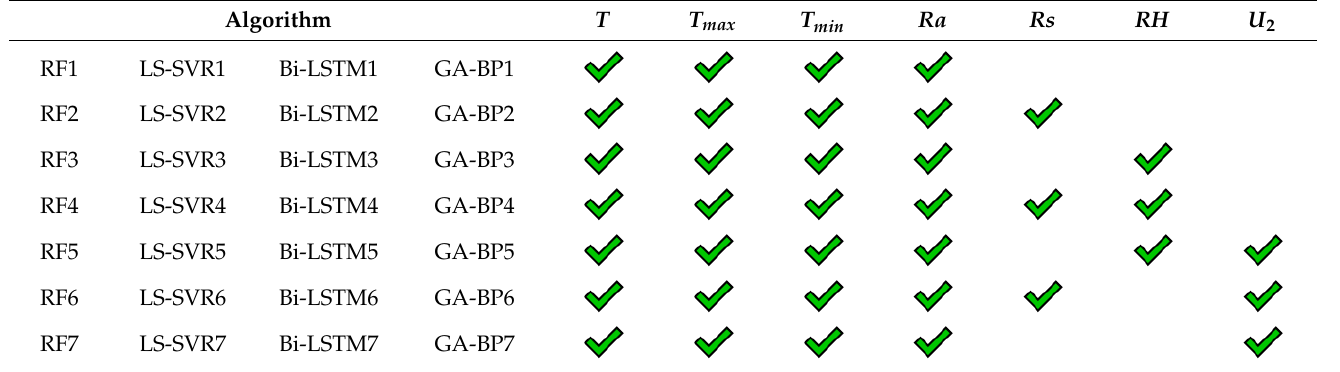
Table 3. Summary of the inputs used for the implementation of each RF, LS-SVR, Bi-LSTM and GA-BP models.